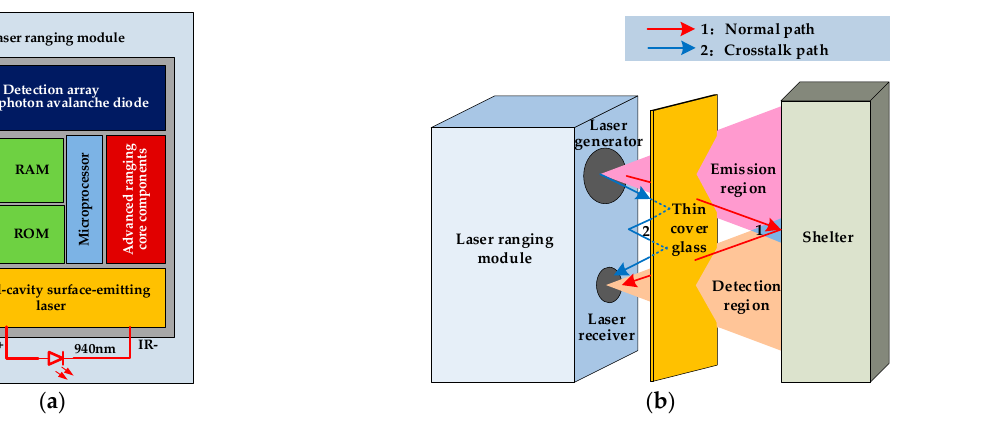
Figure 1. Laser ranging module: ( a ) the internal structure of the VL53L0X laser ranging sensor module; ( b ) schematic diagram.